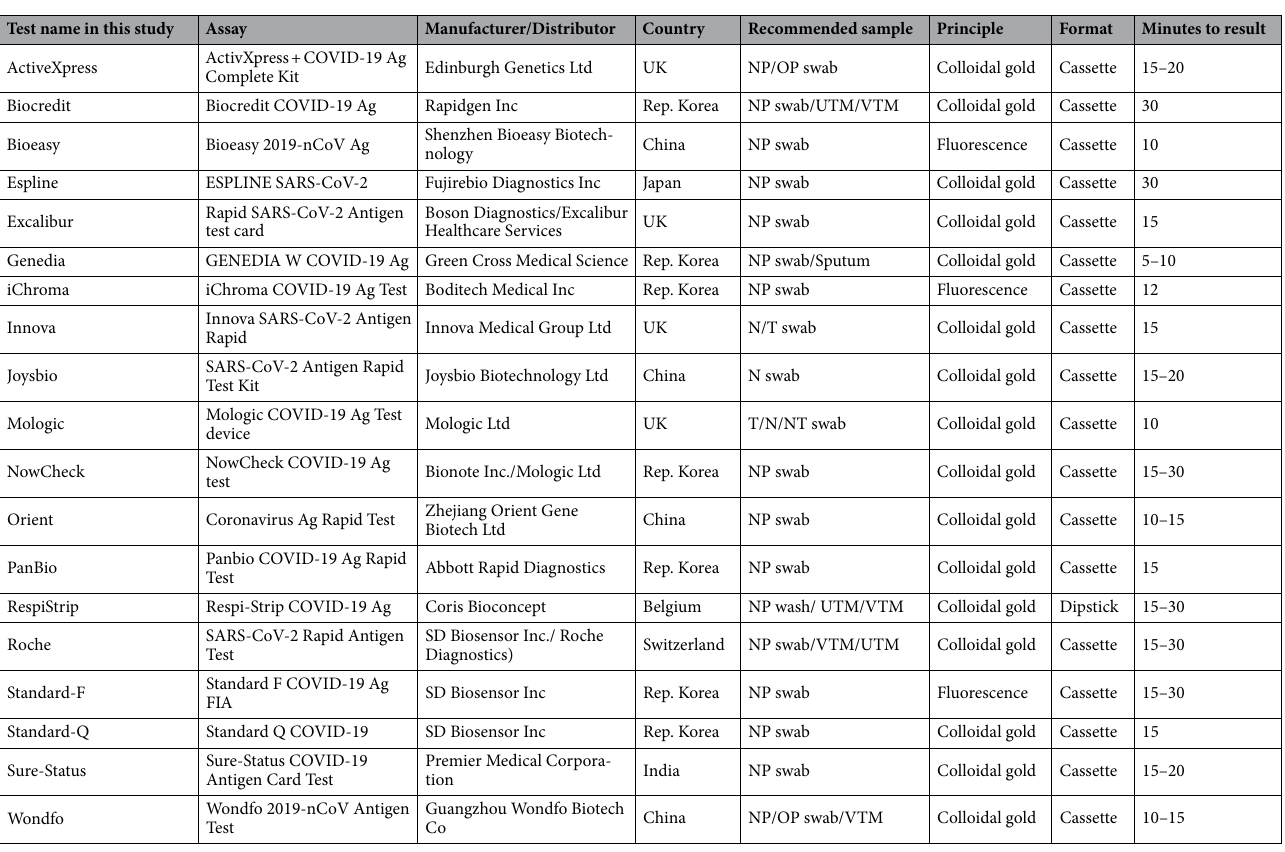
Table 2. Characteristics of the Ag-RDT tested. Rep. Republic, OP oropharyngeal, NP nasopharyngeal, N nasal, T throat, NT nasal-throat, UTM universal transport media, VTM viral transport